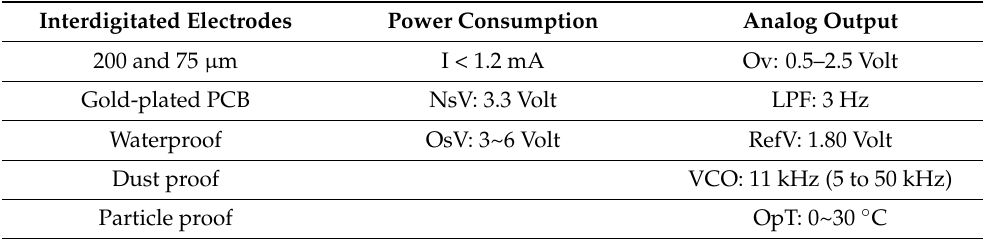
Table 4. Sensing unit electronic